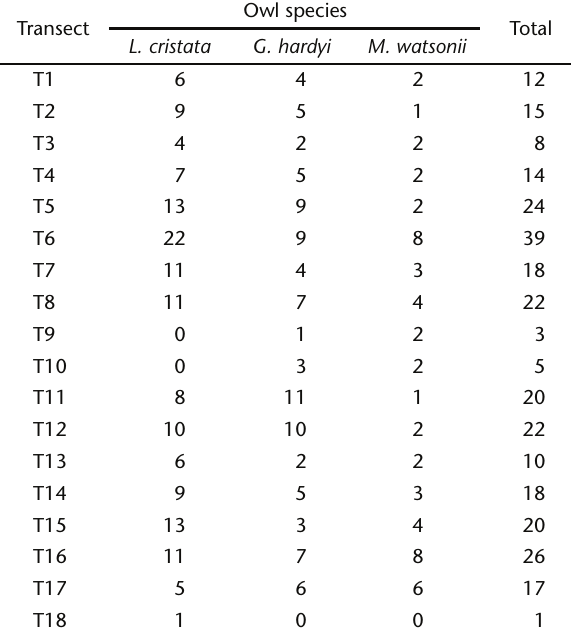
Table IV. Abundance of owls surveyed along the eighteen 8 km transects at Ducke Reserve, central Amazon. Owl Transect